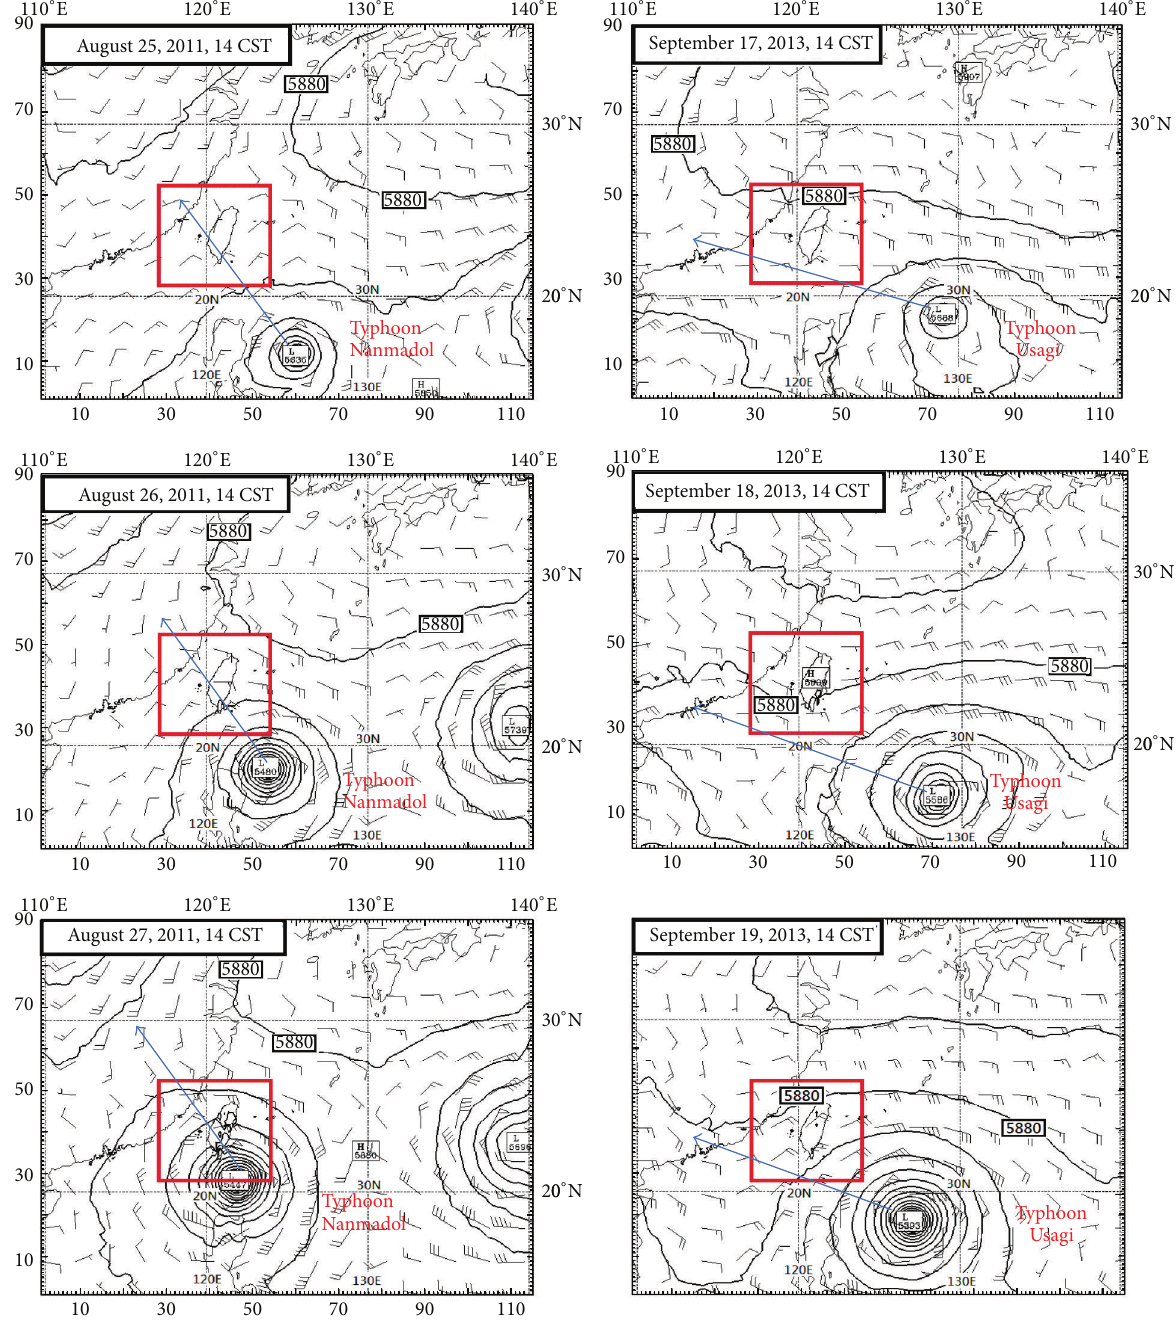
Figure 5: Modeled geopotential height weather charts and horizontal wind vectors (m/s) at 500 hpa model level around Taiwan.